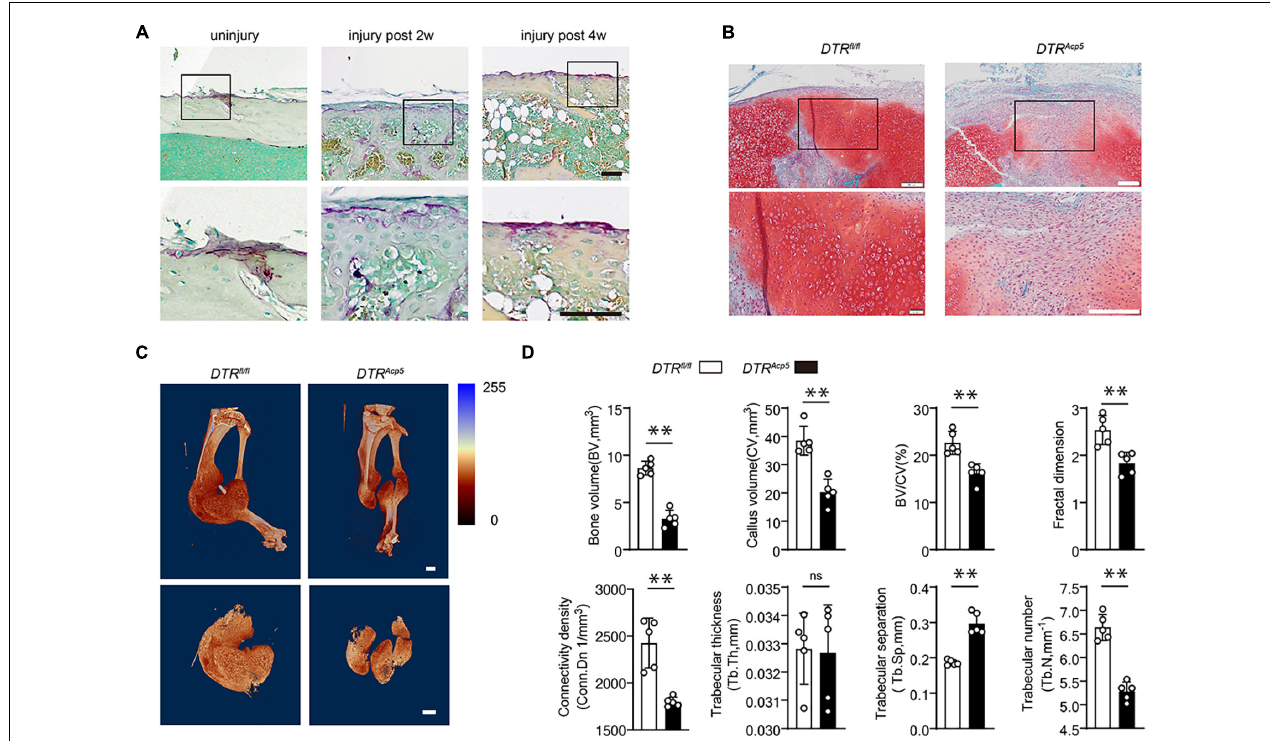
FIGURE 1 | Tartrate-resistant acid phosphatase (TRAP)-positive cell deficiency impairs callus formation during bone healing. (A) Localization of TRAP-positive cells in the periosteum and fracture callus during fracture healing in WT mice. Scale bars, 200 µ m. (B) Representative images of tibia callus Safranin O/Fast green staining on14 days post fractures in WT and DTR Acp 5 mice. Scale bars, 200 µ m. (C) Representative 3D micro-computer tomography ( µ CT) images of tibia bone callus 14 days post fractures. Scale bars, 2 mm. (D) Quantitative µ CT analysis of tibia fractures in DTR Acp 5 mice on 14 days post fractures. The µ CT parameters